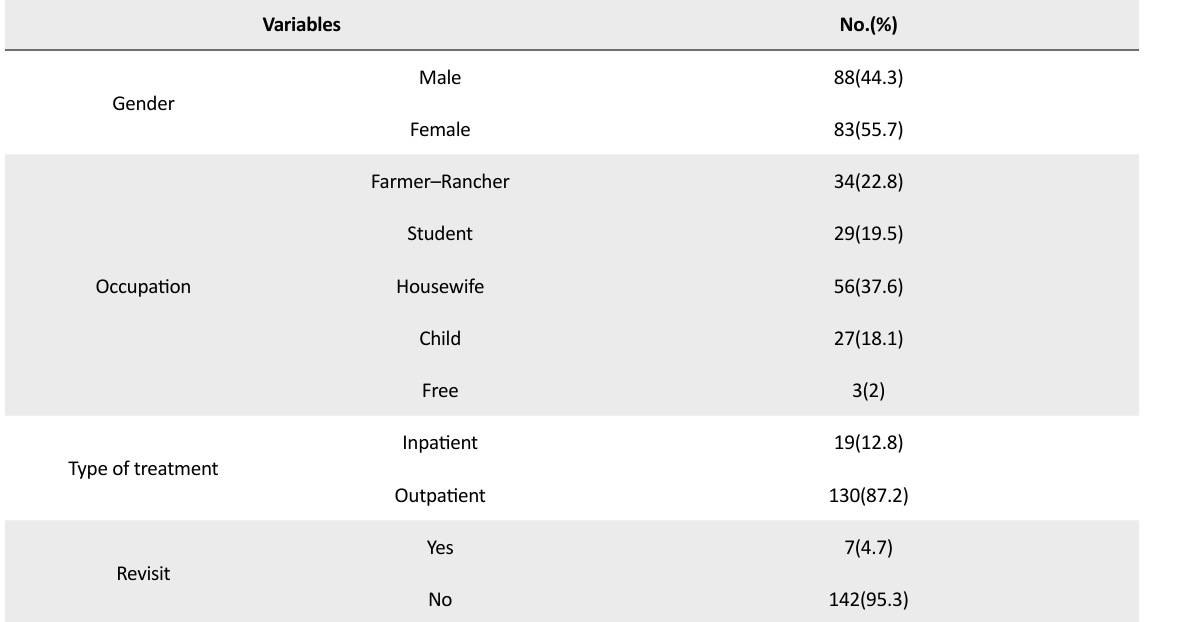
Table 3. Frequency distribution according to the variables